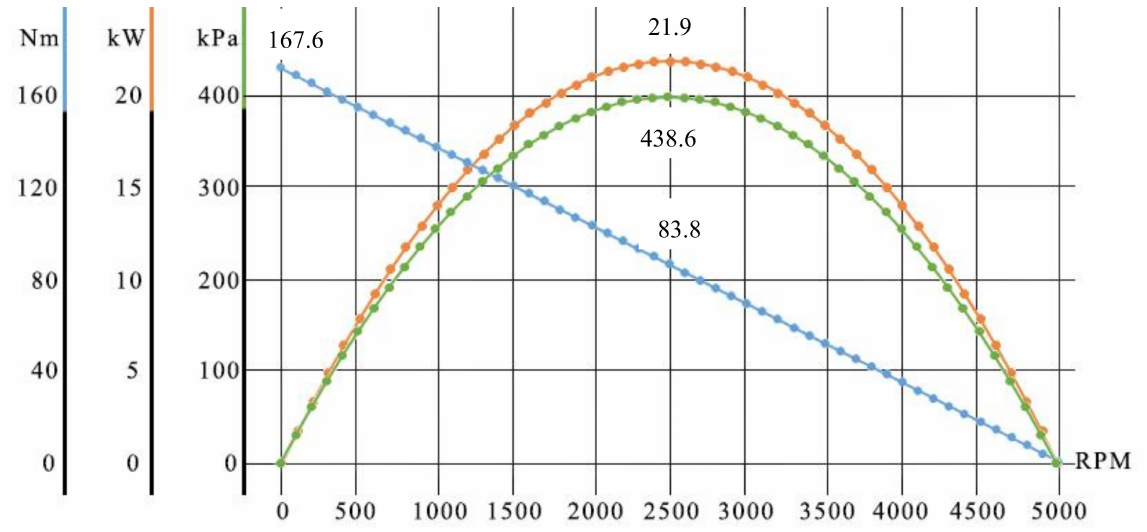
Figure 1. Chart of the specifications’ dependence on the speed. Table 1. Values of torque, power, and pressure drop from the speed of rotation. Rotation Frequency, rpm Torque, Nm Power,